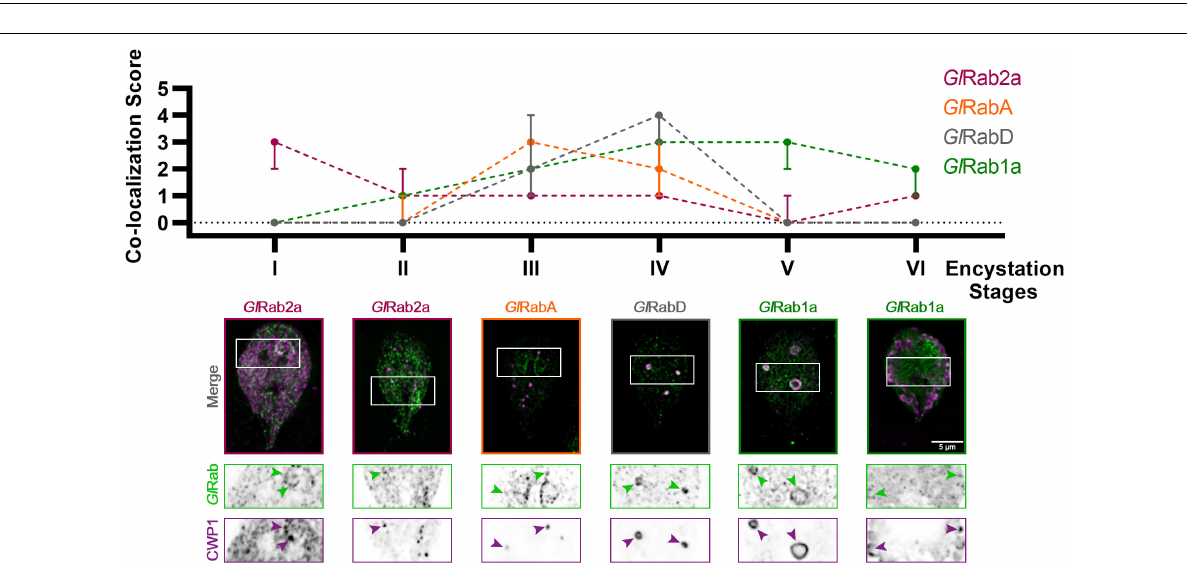
FIGURE 1 | Cyst wall protein trafficking in ESVs during encystation can be divided into stages. Graphic showing trafficking of CWP1-containing ESVs. Once Giardia cells sense the signal to encyst, large amounts of CWM are produced in the ER (Stage I), which then accumulate at ER exit sites (Stage II) and are secreted out into the cytoplasm compartmentalized in ESVs (Stage III). As CWP cargo are sorted and processed, they are separated into phases with CWP1 now being confined to the outer fluid-phase of the ESVs (Stage IV) which grow larger in size as they continue to mature (Stage V). The distinct phases of ESVs are then partitioned into separate vesicles (Stage VI) which are subsequently sequentially secreted to form Giardia’s cyst wall. These stages can be tracked by visualizing CWP1 and tracking ESV morphology. Cells shown here were harvested and fixed at 8 and 24 h p.i.e. then stained with CWP1 antibody.